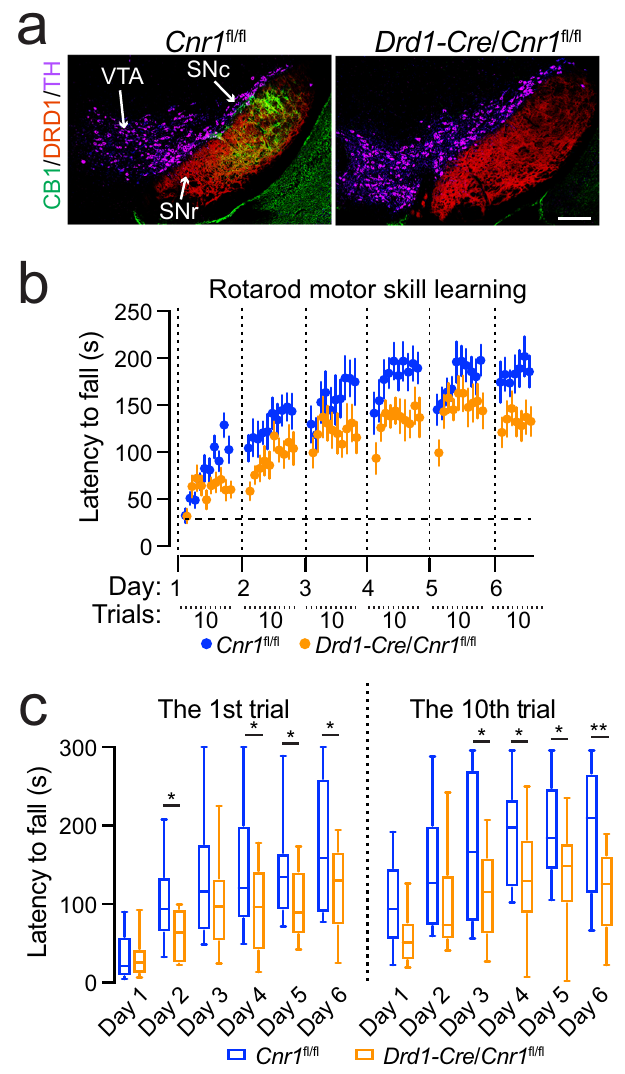
Fig. 6 Genetic deletion of CB1 receptor in dSPNs impairs rotarod locomotor skill learning. a Co-staining of CB1 (green), DRD1 (red), and TH (purple) in the midbrain sections of homozygous fl oxed CB1 ( Cnr1 fl / fl ) and Drd1-Cre/ Cnr1 fl / fl mice. Scale bar: 100 μ m. More than fi ve independent experiments were performed. b Rotarod locomotor skill training of Cnr1 fl / fl ( n = 14, 7 M/7F) and Drd1-Cre/ Cnr1 fl / fl ( n = 12, 6M/6F) mice. Data were presented as mean ± SEM. Two-way ANOVA, genotype: F (1, 24) = 6.301, p = 0.0192. c Box and whiskers plot (the minimum, the 25th percentile, the median, the 75th percentile, and the maximum) of rotarod performance in the fi rst and 10th trial on each day with the same cohorts of Cnr1 fl / fl ( n = 14, 7M/7F) and Drd1-Cre/ Cnr1 fl / fl ( n = 12, 6M/6F) mice. Multiple unpaired t test, two-tailed, * p < 0.05, ** p < 0.005.